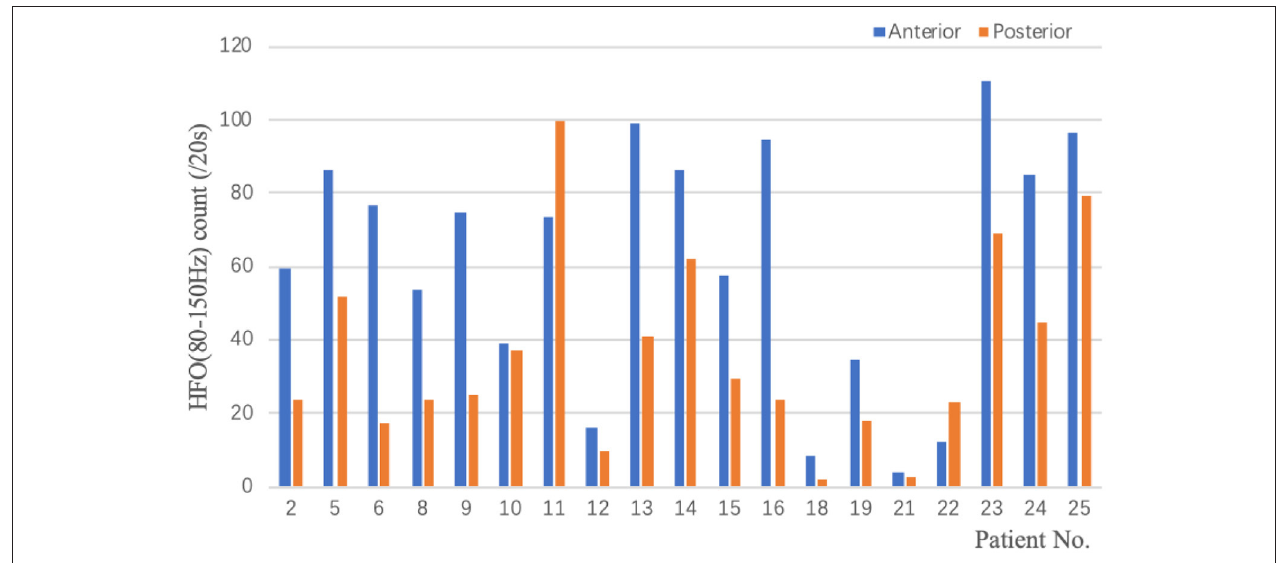
FIGURE 3 | Ictal HFOs of ES on scalp